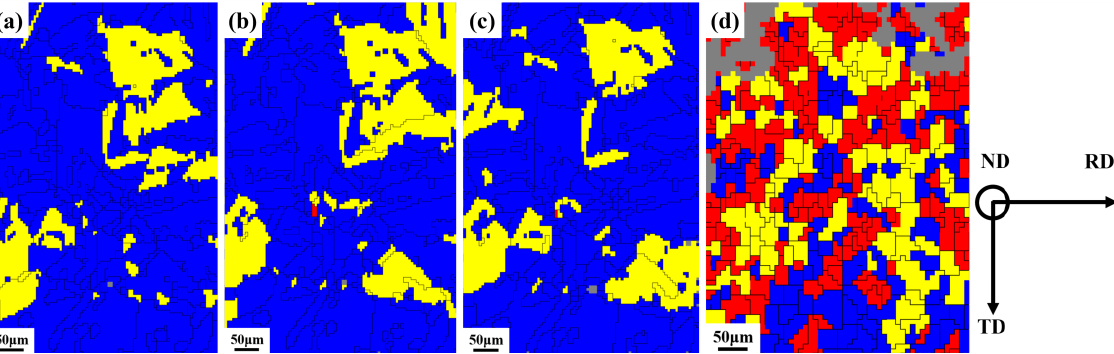
Figure 8. Distribution of recrystallized (blue), substructured (yellow), and deformed (red) ( a ) 0, ( b ) 0.009, ( c ) 0.024, ( d ) 0.09 (RD: rolling direction, ND: normal direction, and TD: transverse direction).